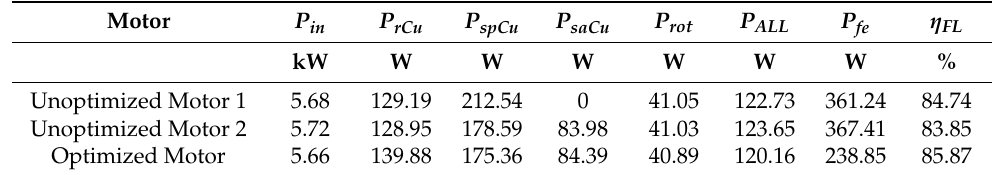
Table 10. Comparison of input power, losses, and efficiency at the nominal torque operating point.